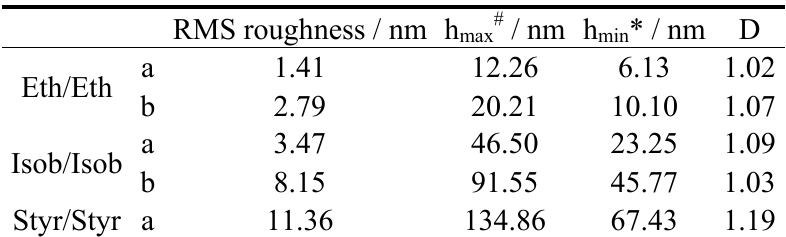
Table 2. Root mean square (RMS) roughness and the fractal dimension D of PECs adsorbed onto